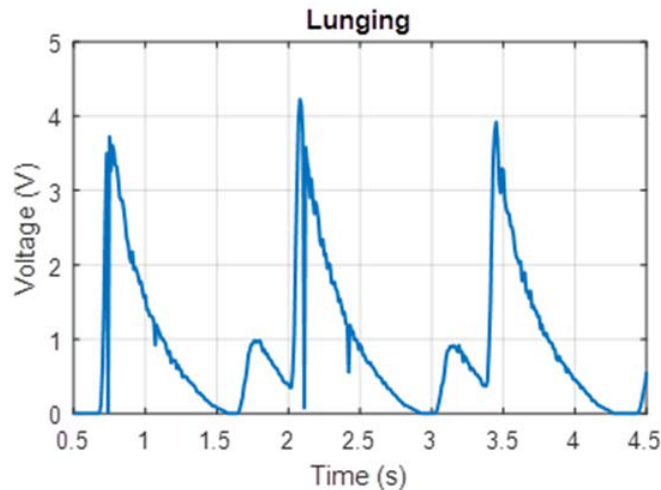
Figure 8. Voltage output measured for Lunges.